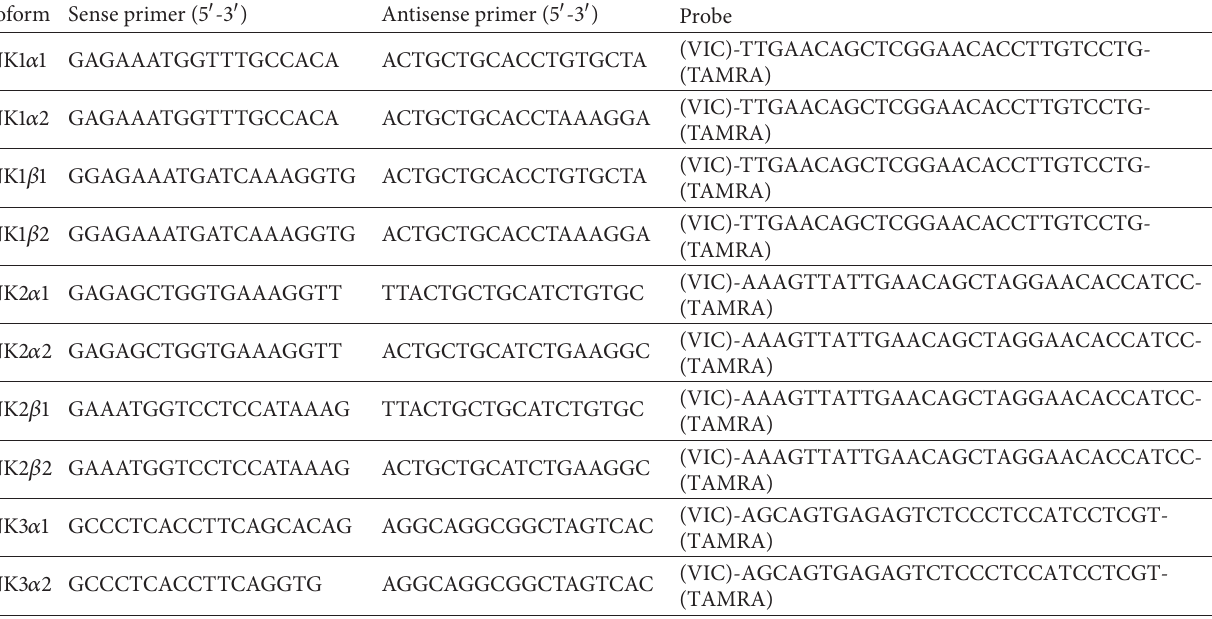
Table 1: Rat JNK isoform-specific